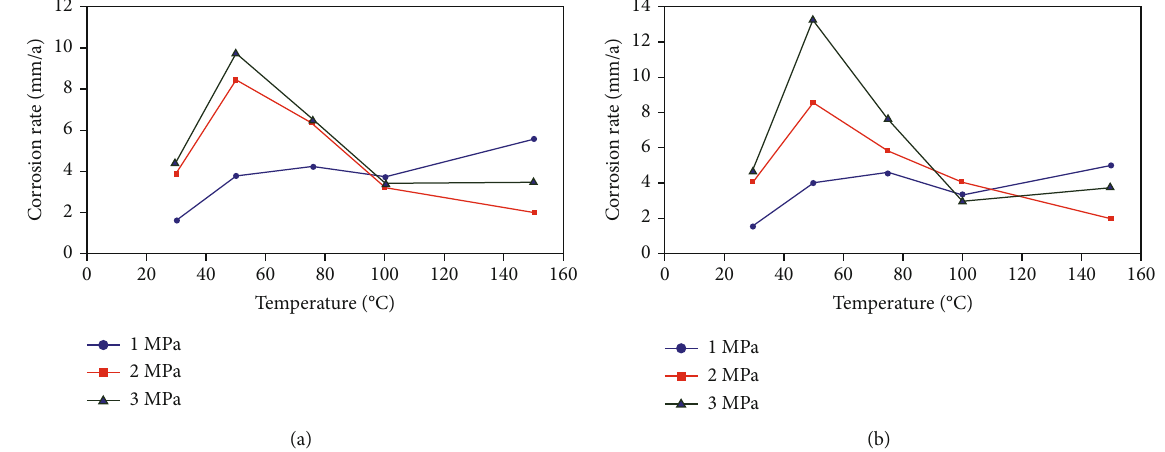
Figure 3: The variation of corrosion rate with temperature in liquid phase. (a) N80, (b) J55.